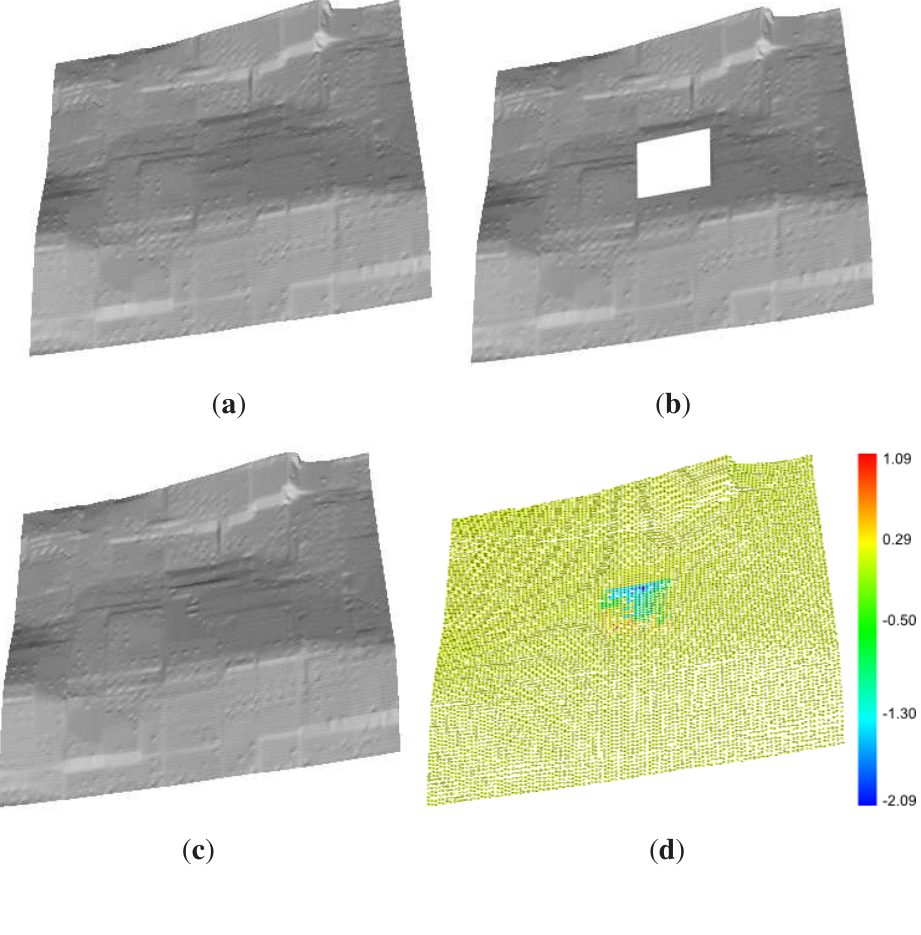
Figure 9. Filling gaps in a DTM on a curved surface on a steep slope: (a) original terrain before a gap is introduced; (b) after a 40 m by 40 m gap has been introduced; (c) after the gap has been repaired; (d) a difference model showing the error in estimation between the original and estimated elevation values. The slope at this location is approximately